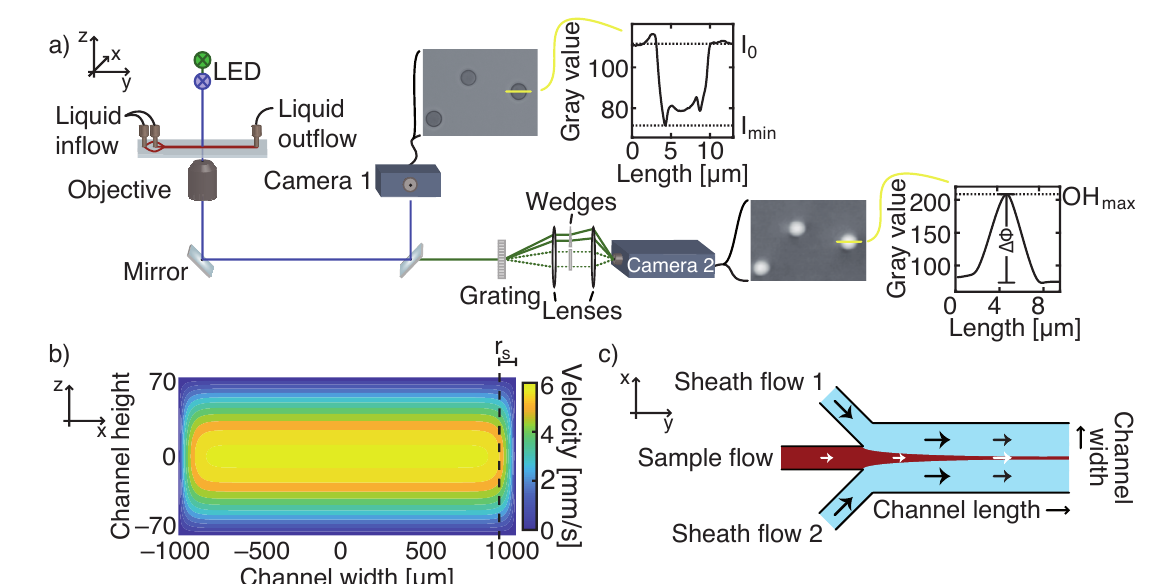
Figure 1. ( a ) Microscopic setup equipped with two LEDs emitting light in blue and green. The light beam travels through a microfluidic channel, where blood cells absorb the light. A dichroic mirror splits the blue light beam, which is captured by a charged-coupled device (CCD)-sensor (camera 1), from the green beam. A diffraction grating is placed in the green path, which separates the sample beam from a reference wave field. By recombining both diffracted beams, a phase shift proportional to a cell’s refractive index and thickness can be observed by a second camera. The yellow line depicts the height profiles of either transmission or phase images. ( b ) The velocity flow profile of a laminar flow in a rectangular microfluidic channel for a flow rate of Q =0.06 mL/min. The side region r s indicates the part of the flow profile where the fluid velocity at the channel mid-height deviates by more than 2.5% from the maximum velocity. Rectangular cross section is not to scale. ( c ) Illustration of hydrodynamic focusing of a sample flow by two adjoining sheath flows. By tuning the flow rates of each inlet, the width of the sample stream can be adjusted to the FOV (field of view) of the